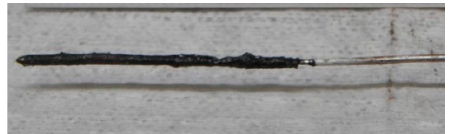
Figure 6. Tellurium-coated iridium wire (before washing/cleaning).